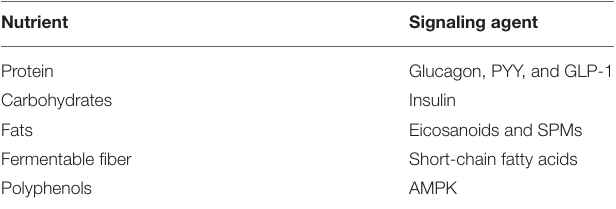
TABLE 2 | Dietary nutrients and their signaling agents in the resolution response. Nutrient Signaling agent Protein Glucagon, PYY, and GLP-1 Carbohydrates Insulin